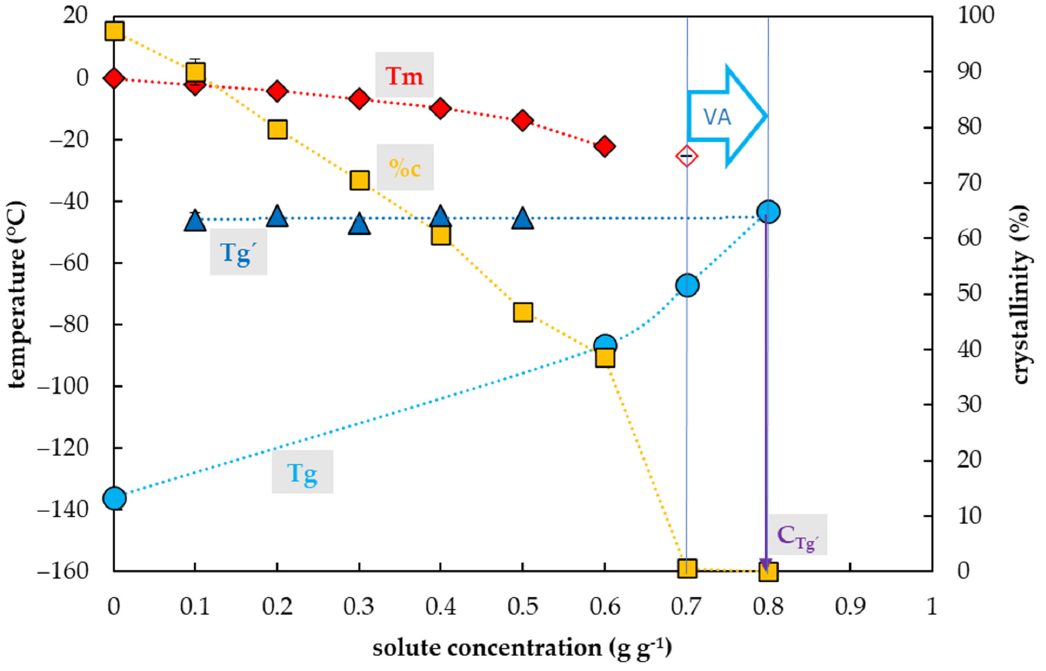
Figure 6. Thermal characteristics of sucrose (Suc) depending on its concentration in an aqueous solution. The total concentration of solutes is expressed as the mass of solutes (g) per mass of aqueous solution (g). The left y -axis indicates the temperature of thermal events, right y -axis shows the percentage of water crystallinity based on the total mass of the solution. The temperature of the glass transition (Tg) of the solution is indicated by a cyan circle, the Tg’ originating from the freeze-concentrated solution during the cooling period is indicated by a blue triangle, onset of the water melting peaks (Tm) is indicated by a red diamond if the effect occurs during the cooling period, the onset of the water melting peak is indicated by a hollow diamond if the effect occurs during the warming period. The percentage of crystallinity of water (%c) based on the total mass of the solution is indicated by an orange square. The vitrification ability (VA) demonstrates the range of solute concentrations with the appropriate vitrification ability. Cg´ indicates a concentration of the freeze-concentrated solution. All effects were measured during the warming period of the C/W cycles at a rate of 10 °C min − 1 . Results are presented as a mean of three repetitions and vertical bars represent standard error.